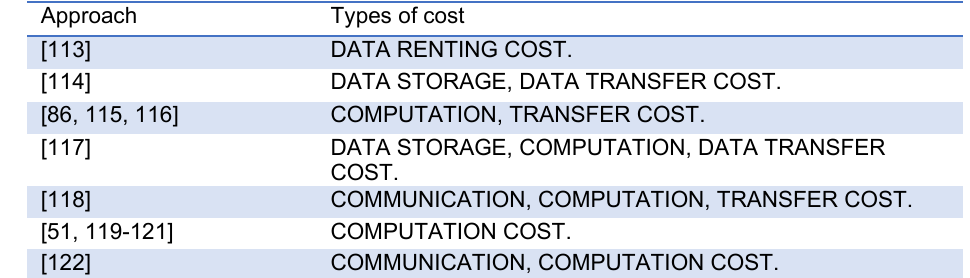
Table 3. Types of cost used in meta-heuristic techniques